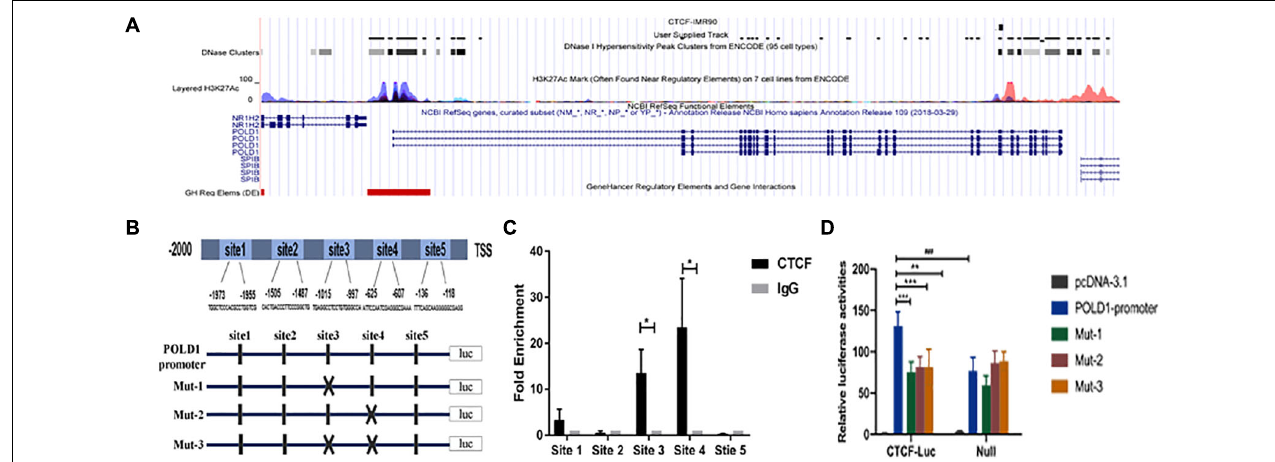
FIGURE 1 | CCCTC-binding factor (CTCF) mainly binds to the DNA polymerase delta 1, catalytic subunit (POLD1) promoter in two sites. (A) ENCODE database analysis showing potential CTCF-binding sites in the POLD1 promoter. (B) The JASPAR database predicted five higher score binding sites of CTCF to the POLD1 promoter, and the mutations of the two CTCF-binding sites were designed. (C) The binding sites of CTCF to the POLD1 promoter were analyzed by chromatin immunoprecipitation (ChIP) assay in lymphocyte cells ( n = 40). * P < 0.05 vs. IgG-negative control group. (D) Luciferase activity assay demonstrated that the CTCF led to an increase in POLD1 promoter activity and that mutation of site 3 or 4 greatly reduced promoter activity in HEK293T cells ( n = 3). ** P < 0.01, *** P < 0.005 vs. POLD1 promoter wild type (WT) + CTCF. ### P < 0.001 vs. POLD1 promoter WT. Data were analyzed using Student’s t -test, and data are shown as mean ± SEM, with three independent experiments in each